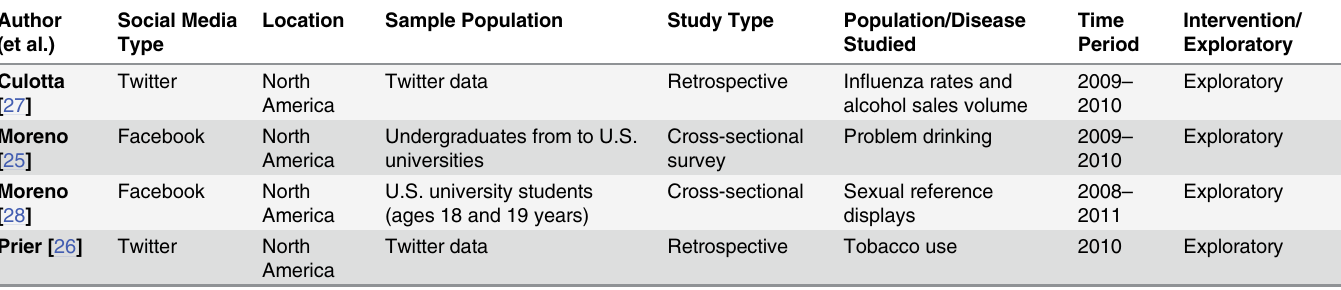
Table 5. Characteristics of 4 non-infectious disease studies addressing research question 1 a . Author (et